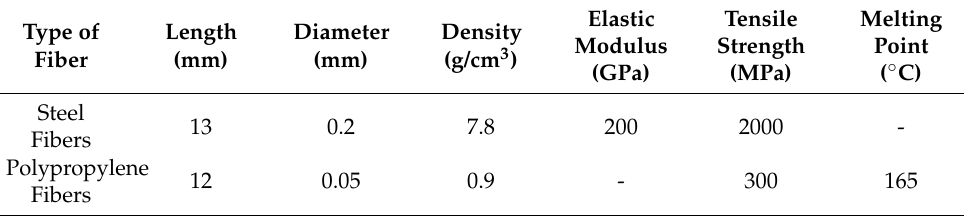
Table 4. The physical and mechanical properties of the